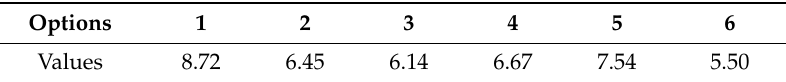
Table 1. Average values for the six options.